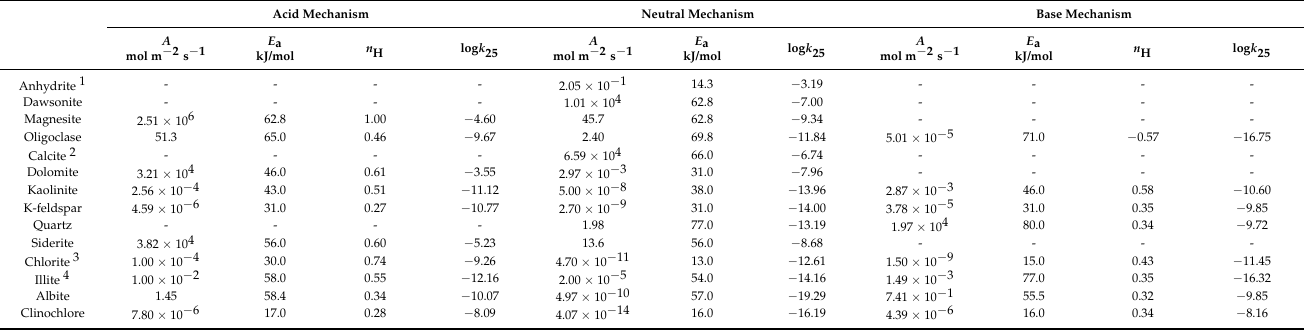
Table 5. Kinetic parameters in the